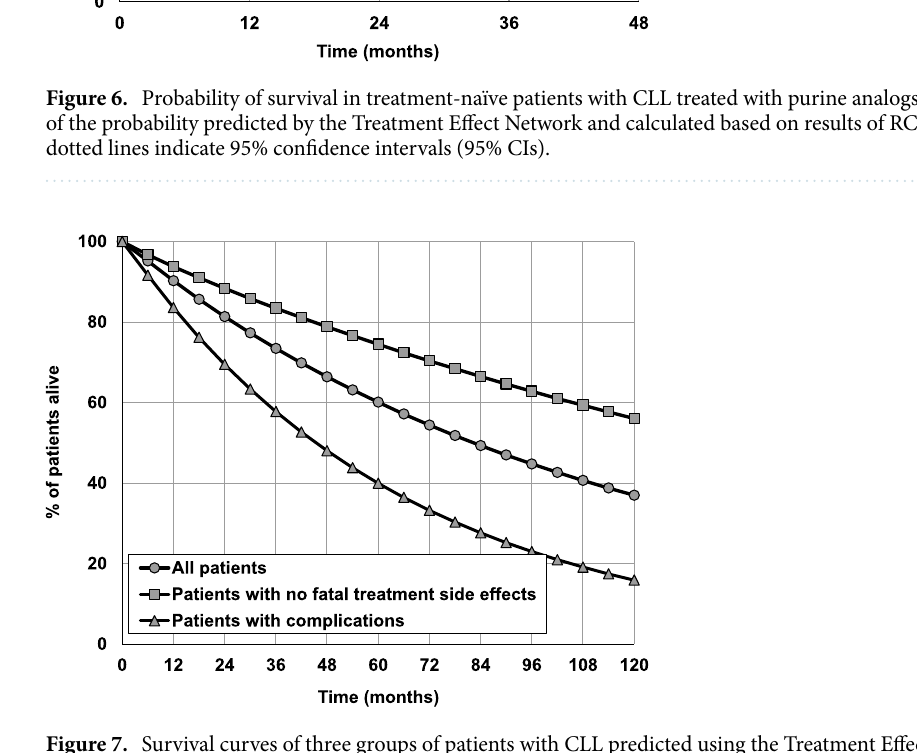
Figure 7. Survival curves of three groups of patients with CLL predicted using the Treatment Effect Network. Comparison of the results predicted in patients with complications, patients with no fatal treatment side effects and all